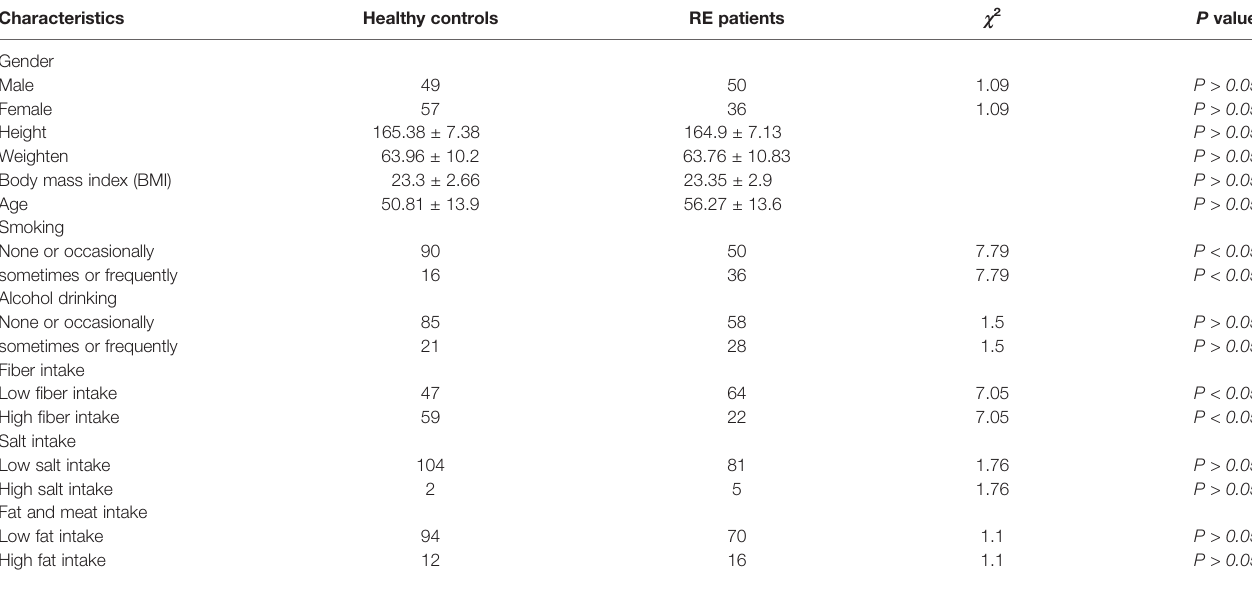
TABLE 1 | Basic information of Re fl ux Esophagitis (RE) patients and healthy controls.